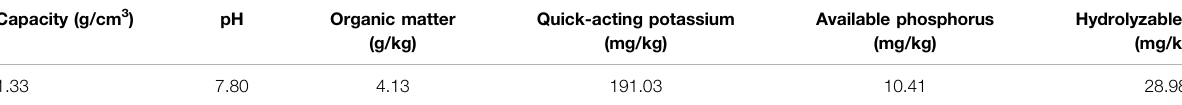
TABLE 5 | Physicochemical properties of soils in reclaimed areas.